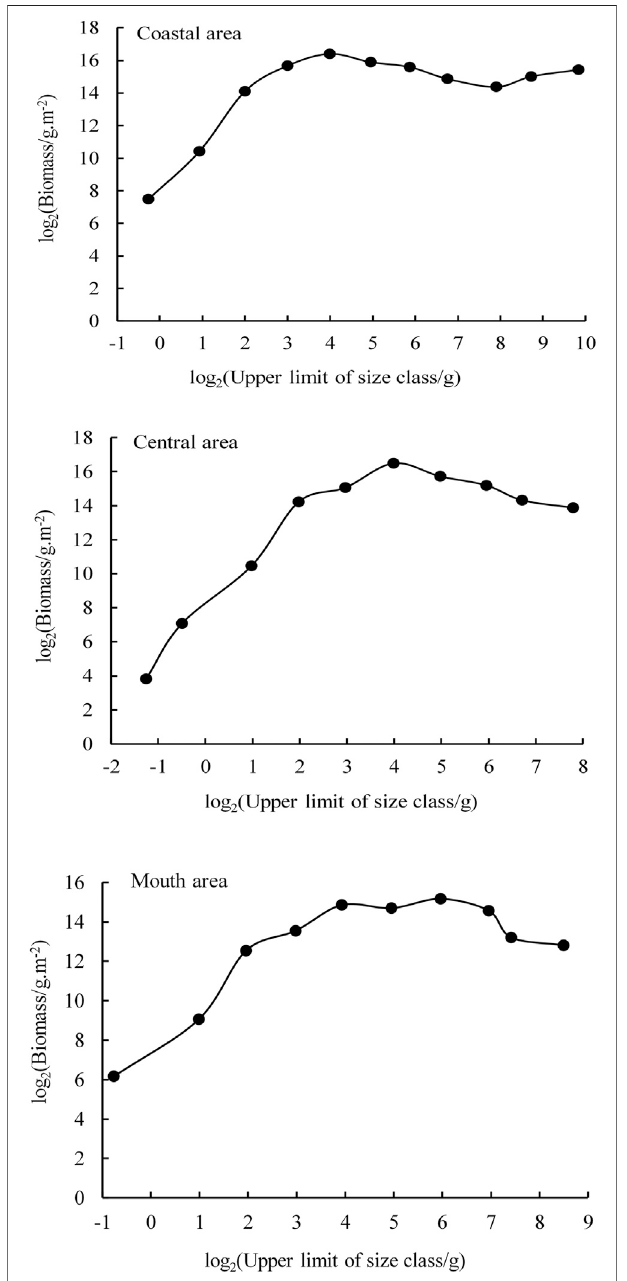
FIGURE8| Sheldontypebiomasssizespectrumof fi shindifferentareas of Daya Bay.